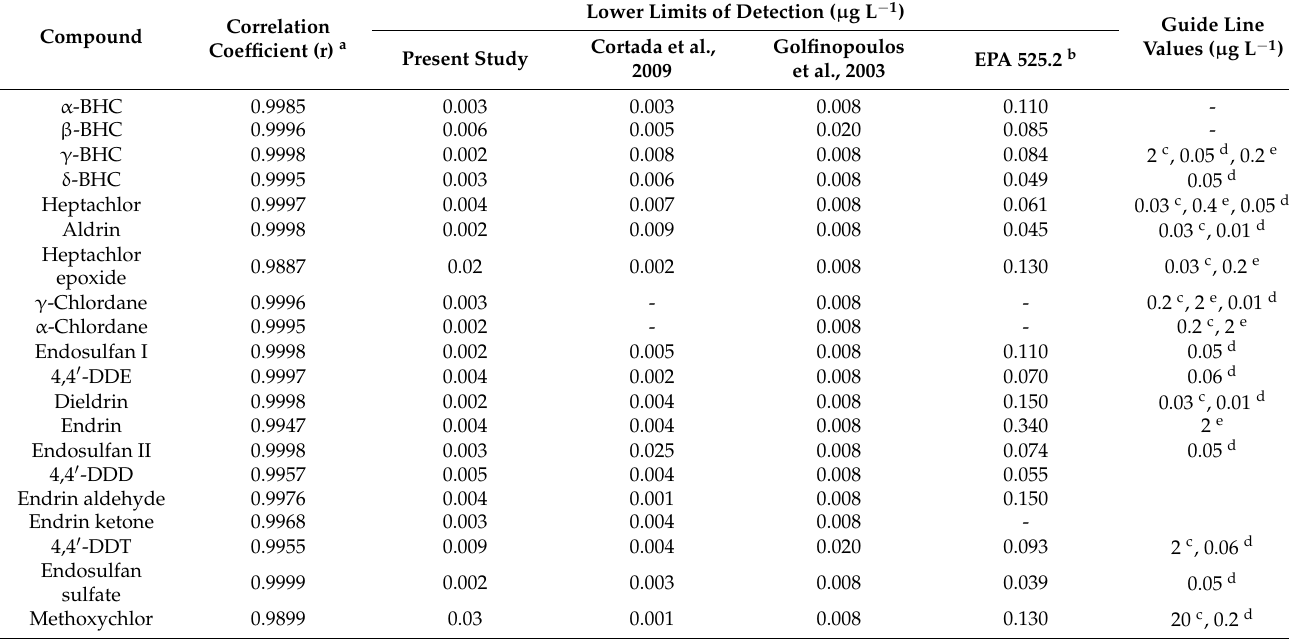
Table 2. The Linear range, R 2 values, lower limits of detection and WHO guideline values for selected pesticides. Correlation Compound Coefficient (r)